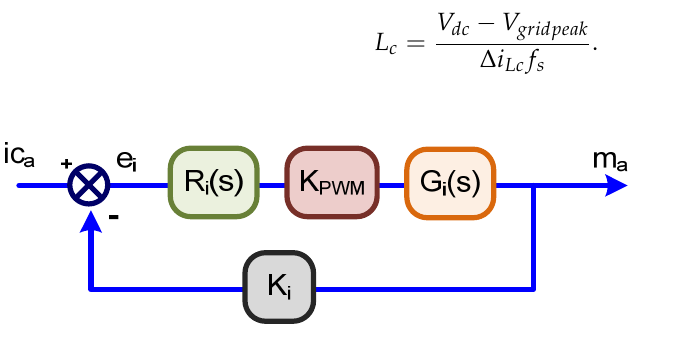
Figure 4. Current control loop—PhaseA.